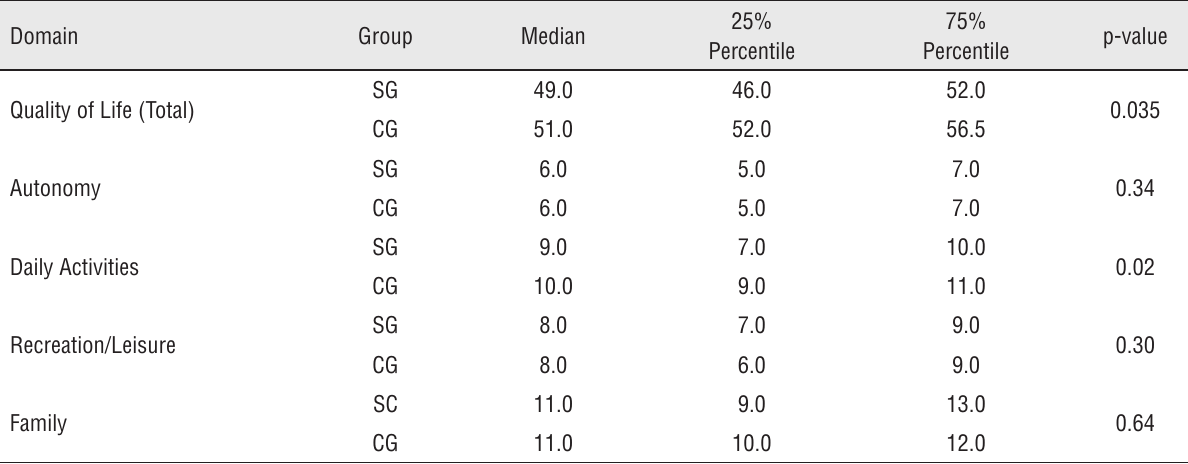
Table 2 - Evaluation of QOL according to each domain of AUQUEI.